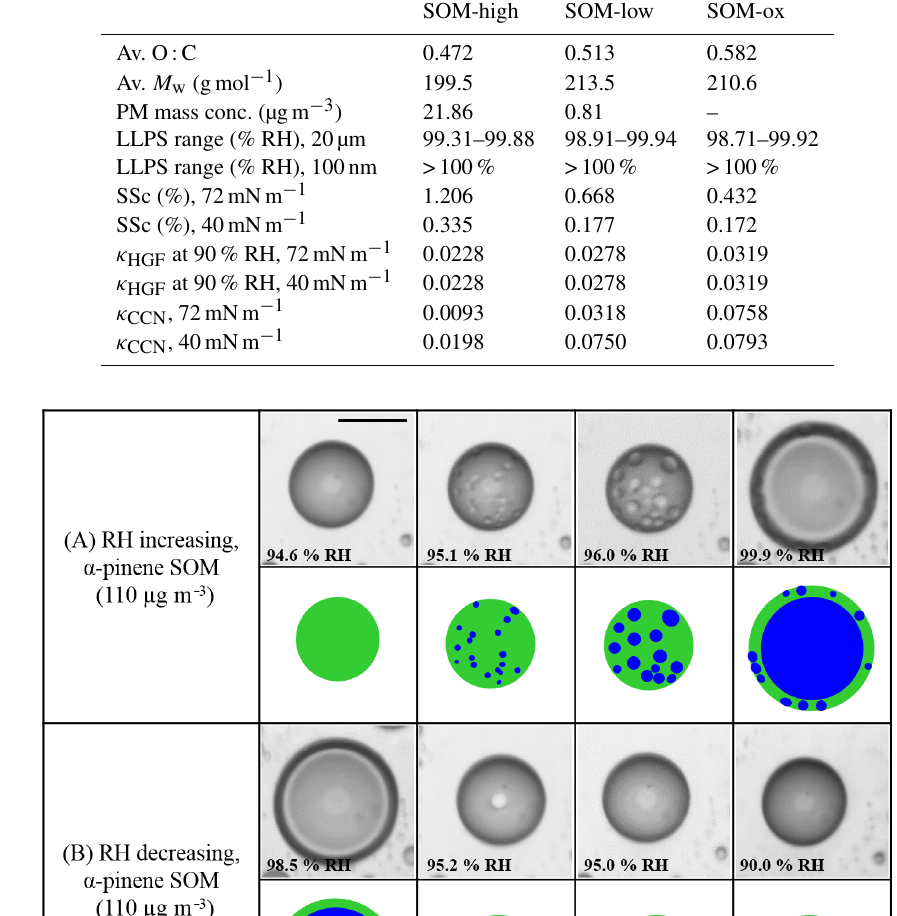
Table 3. Calculated properties of the mixtures SOM-high, SOM-low and SOM-ox: average O:C elemental ratio, average molecular weight, simulated mass yields at 60% RH reported in Zuend and Seinfeld (2012), range of LLPS for a 20µm particle in diameter, range of LLPS for a 100nm particle in diameter, critical supersaturation SSc for a 100nm particle with a surface tension of 72mNm − 1 , critical supersaturation SSc for a 100nm particle with a surface tension of 40mNm − 1 , κ HGF from the hygroscopic growth curve at 90% RH for a 100nm diameter particle and surface tension of 72mNm − 1 , κ HGF from the hygroscopic growth curve at 90% RH for a 100nm diameter particle and surface tension of 40mNm − 1 , κ CCN from SSc of the Köhler curve for a 100nm particle and surface tension of 72mNm − 1 , κ CCN from SSc of the Köhler curve for a 100nm particle and surface tension of 40mNm − 1 .